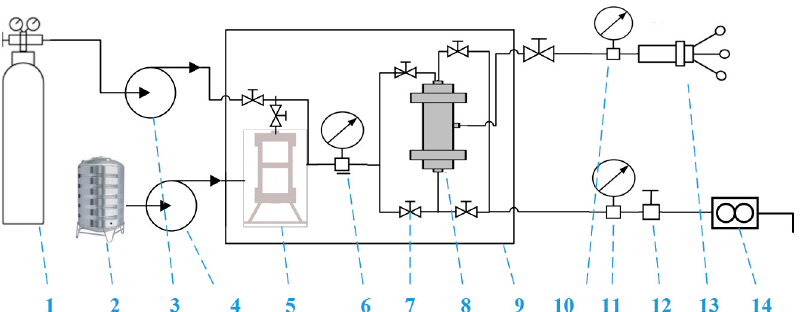
Figure 3. Schematic diagram of the multi-functional core displacement device. 1—gas cylinder; 2—